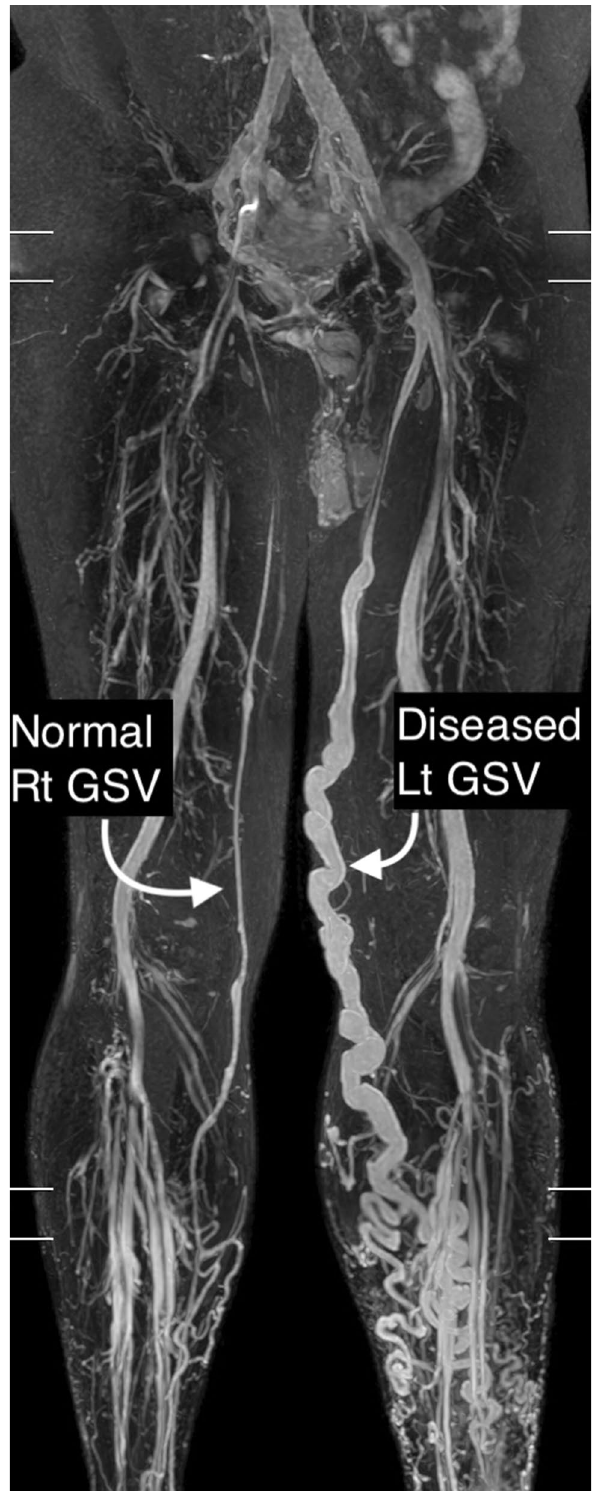
Figure 4. TRANCE-MRI image of a 68-year-old patient with venous reflux in the great saphenous vein of the left